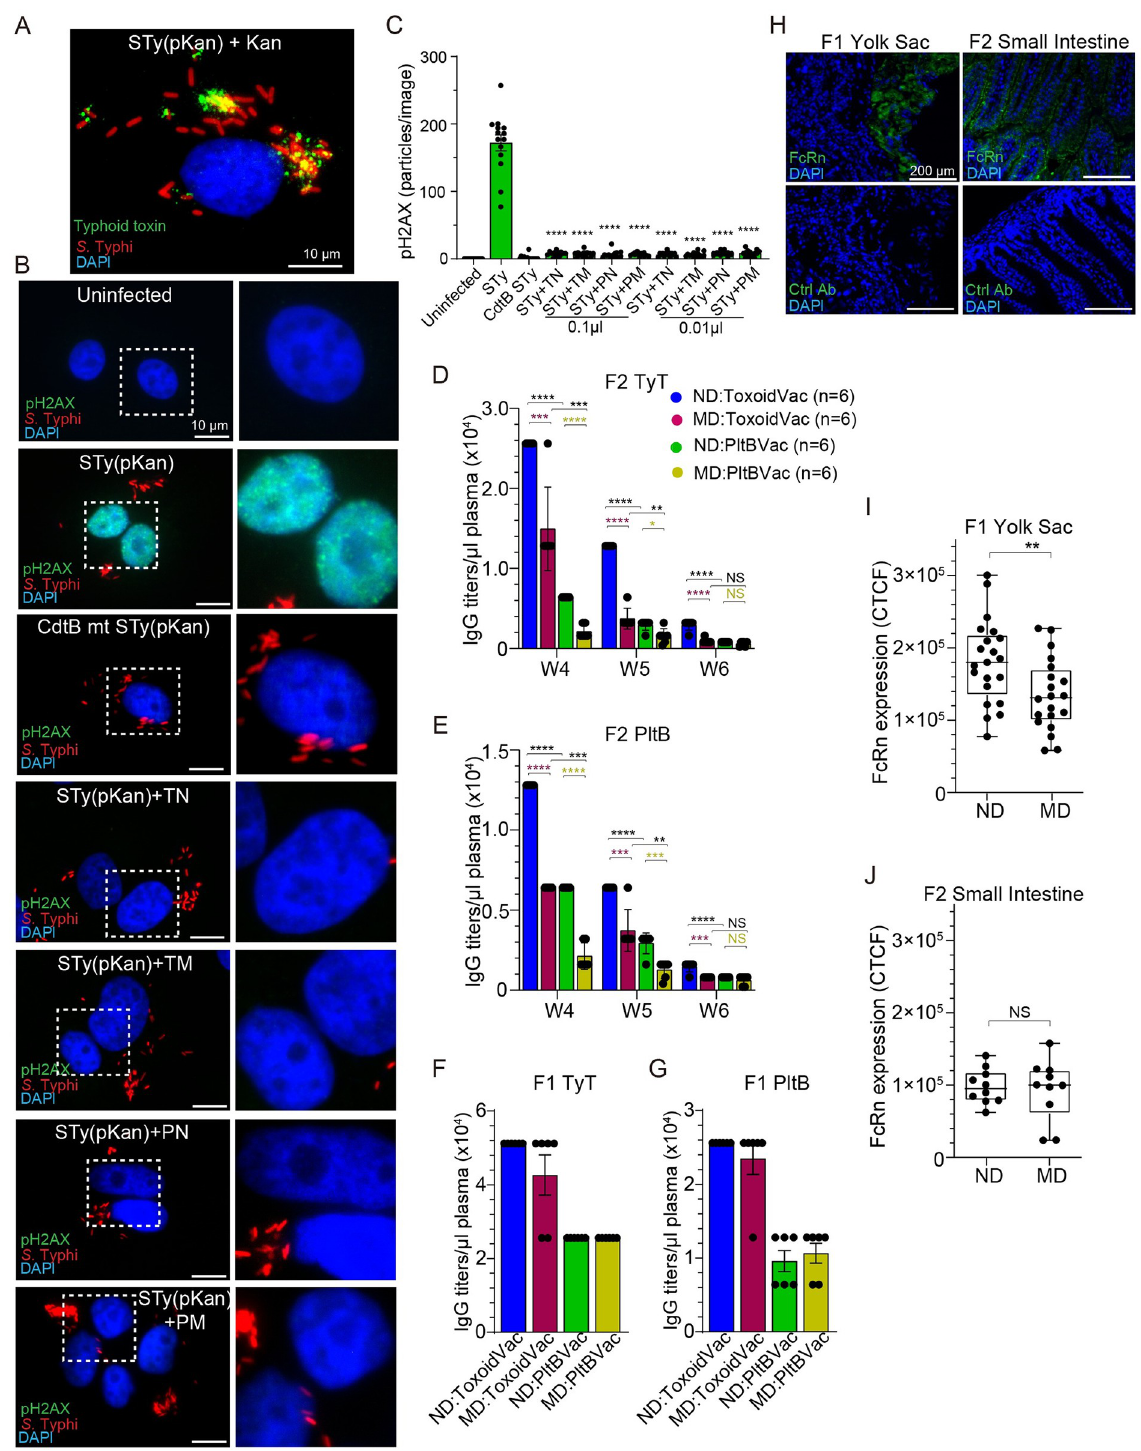
Fig 4. Unlike F1 mothers, MD progenies had a significantly lower level of typhoid toxin neutralizing antibodies. A , Representative fluorescence microscope image showing typhoid toxin (green) secreted by S . Typhi (red) in kanamycin-resistant S . Typhi-infected host cells (blue for host cell DNA). STy(pKan), S . Typhi carrying the pKan plasmid. Kan, 50 μ g/mL kanamycin treatment. Scale bar, 10 μ m. B , Representative fluorescence microscope images showing pH2AX (green, reflecting host cell DNA damage repair response), S . Typhi(pKan) (red), and host cell DNA (blue). Zoom-in images (right panels) correspond to the dotted boxes in the overall images (left panels). Scale bar,